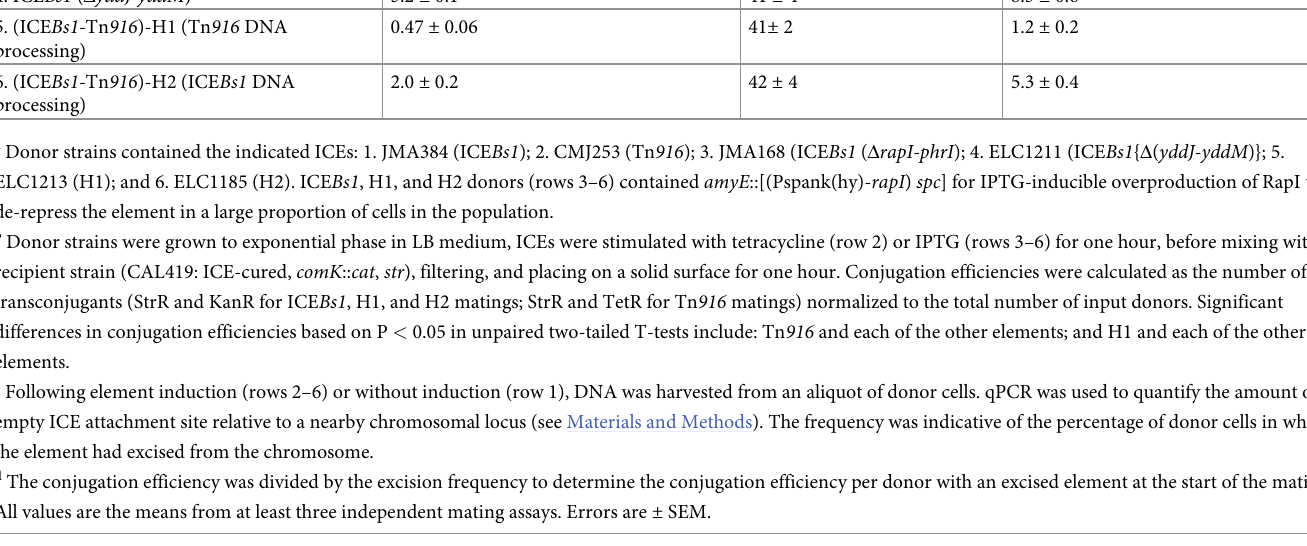
Conjugation frequencies were measured by mixing the donor cells containing either Tn 916